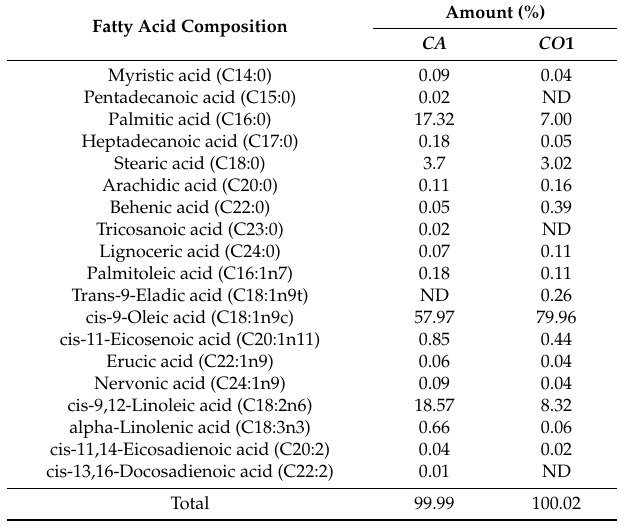
Table 1 . Fatty acid composition of tea seed oils ( CA ) and commercial tea seed oils ( CO 1 ).